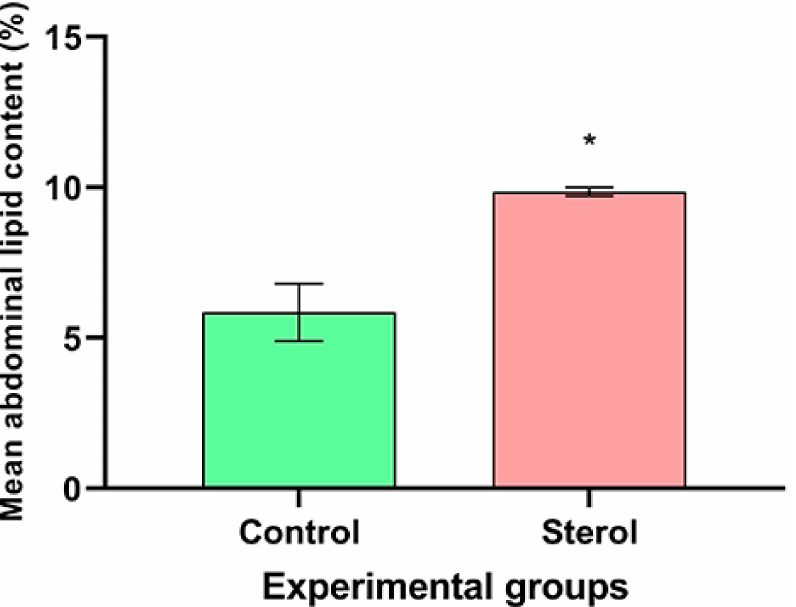
Figure 4. Mean abdominal lipid content (%) at the end of the four-week study. Control: honey bees fed diet with no sterol; Sterol: honey bees fed diet containing 0.25% 13 C-labeled 24-methylenecholesterol. Error bars indicate standard errors for means. * Indicates statistically significant di ff erences at p <